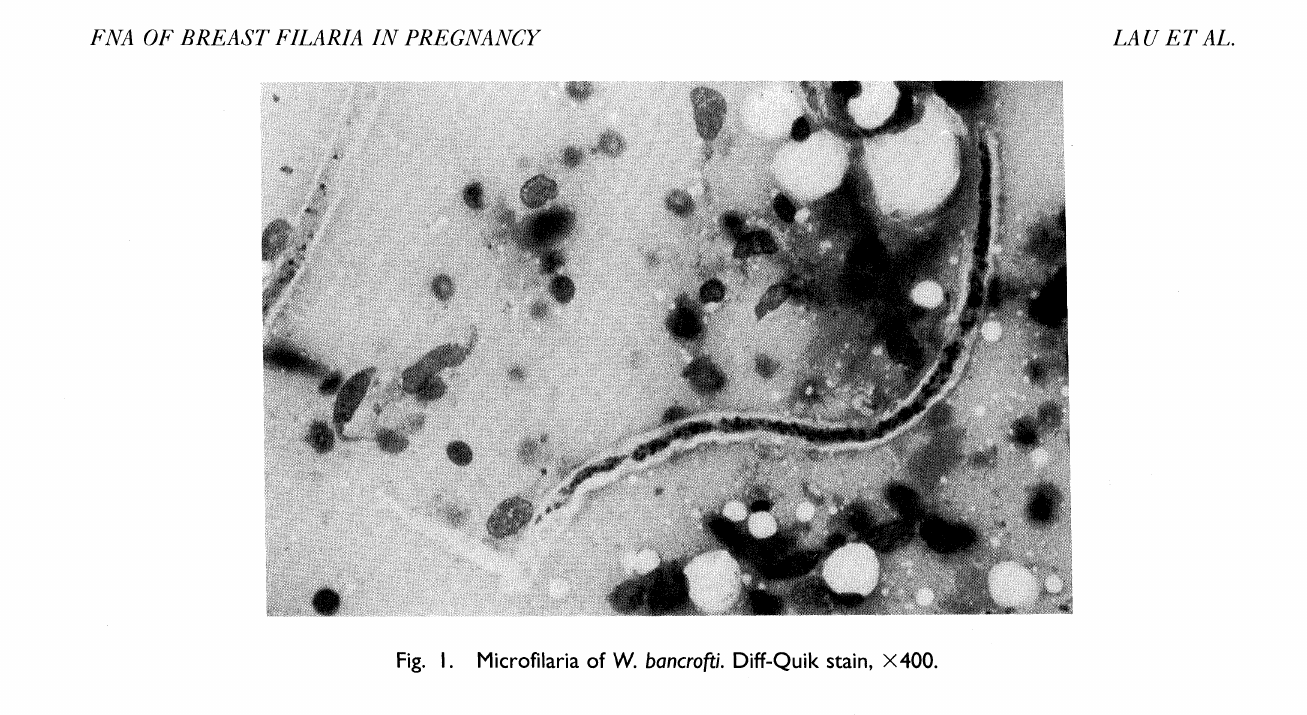
Fig. I. Microfilaria of W. bancrofti. Diff-Quik stain,